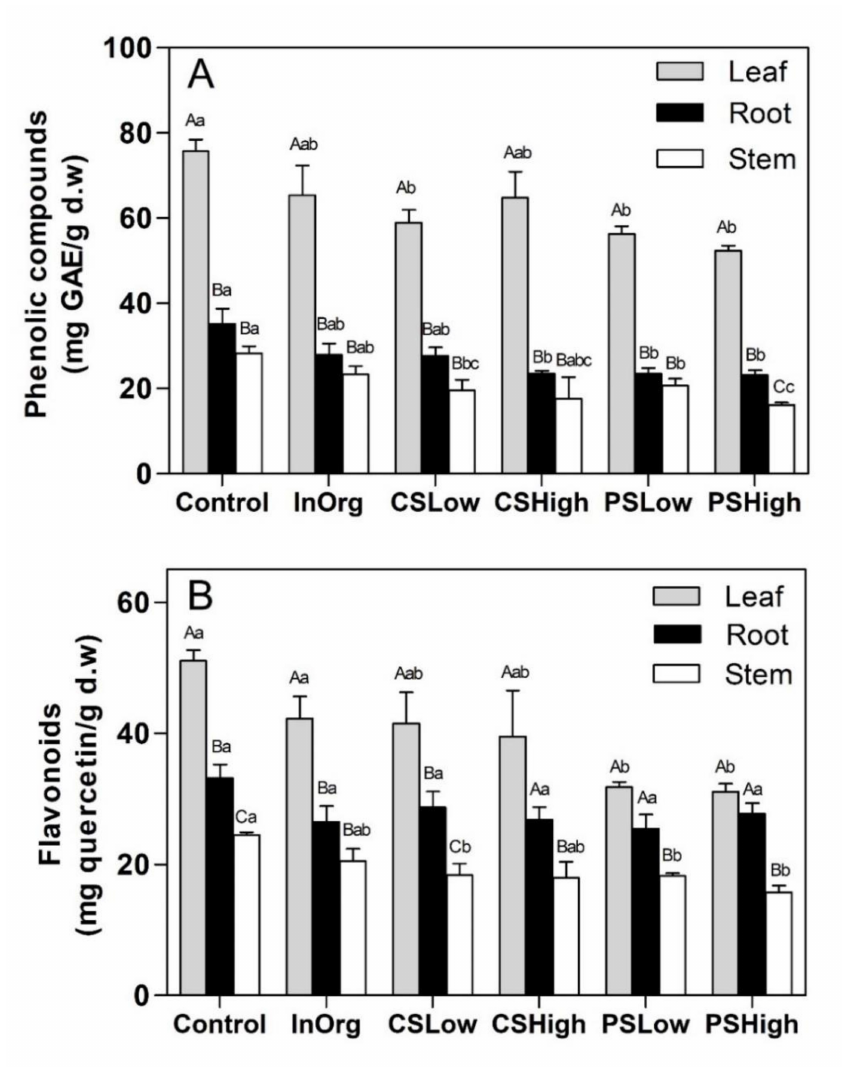
Figure 4. ( A ) Total phenolics and ( B ) total flavonoids in leaves, roots and stems of Rosmarinus o ffi cinalis plants in the various fertilization treatment groups: InOrg, CS Low , CS High , PS Low and PS High . Vertical bars indicate standard errors of the mean ( n = 3). Di ff erent lowercase letters indicate significant di ff erences among fertilization treatments ( p < 0.05). Di ff erent capital letters indicate significant di ff erences among plant parts ( p <